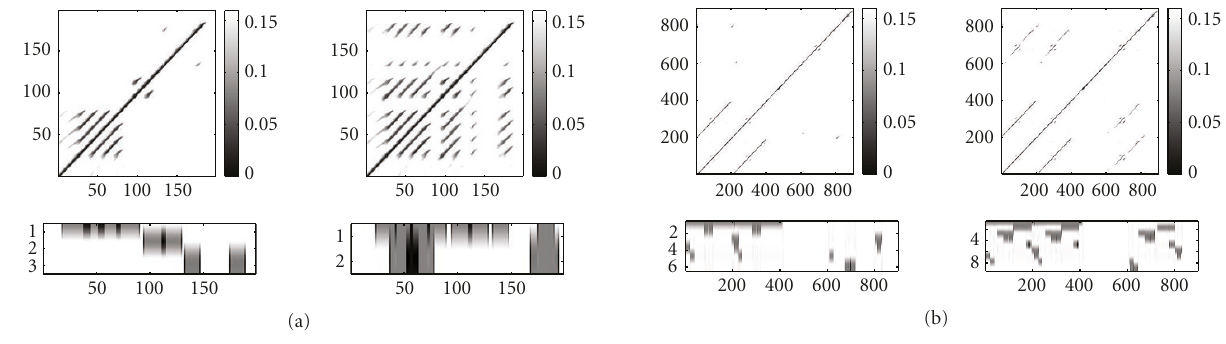
Figure 15: (a) Zager & Evans, “In the year 2525.” Left: S with the resulting similarity clusters. Right: σ min ( S ) with the resulting similarity clusters. The parameters are fixed as described in Section 6.1. (b) Schubert, “Unfinished,” first movement, D 759, conduced by Abbado. Left and right parts are analogous to